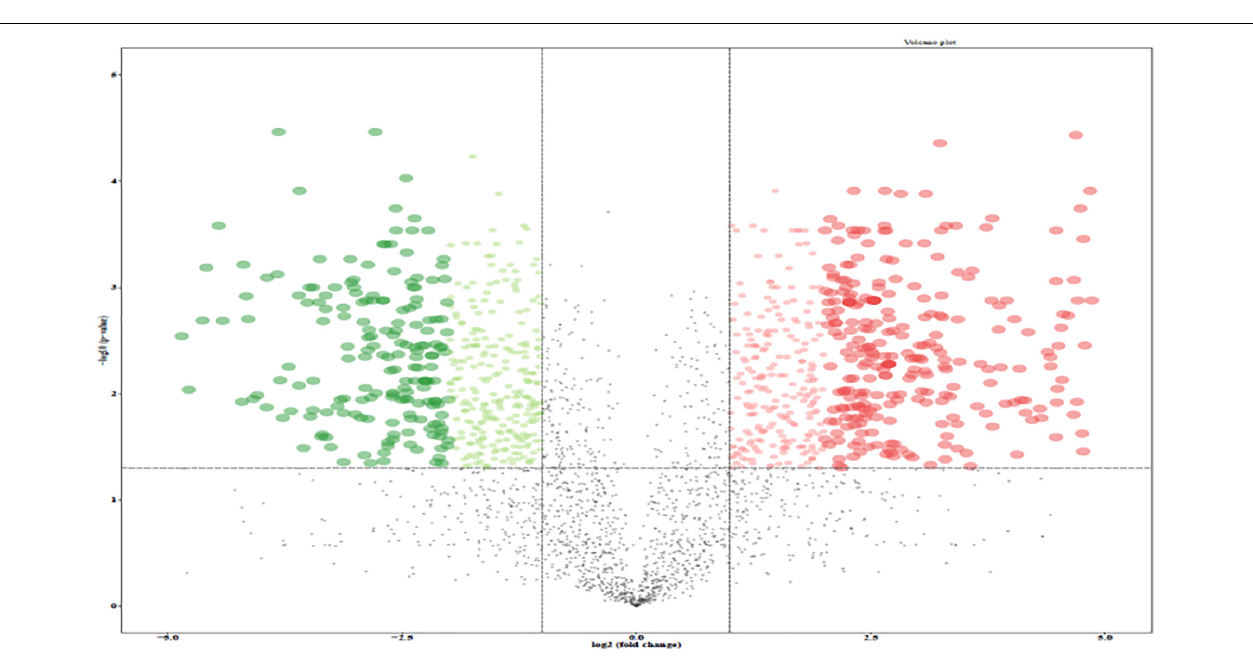
FIGURE 3 | Transmission electron microscopic images of T. rubrum of control group and 256 µ g/mL group (A) control group; (B) 256 µ g/mL group.